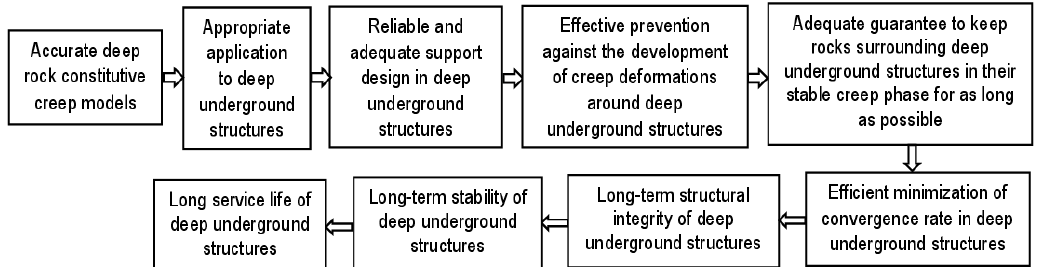
Figure 11. Diagram showing the importance of accurate constitutive rock creep models to ensure the long-term life of deep tunnels, including deep caverns and mines.